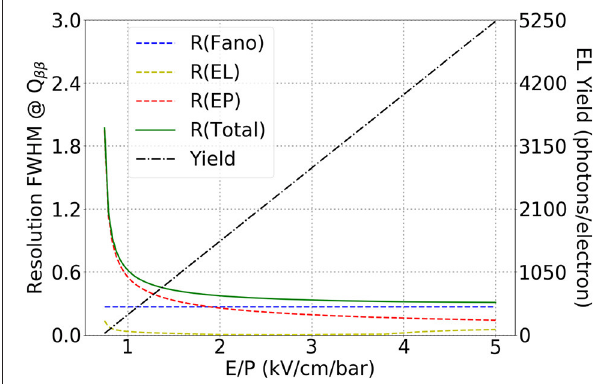
FIGURE 3 | Energy resolution terms and EL yield characteristic of a HPXe-EL TPC as a function of the reduced electric field for an EL gap of 6mm a value of k 0.016 and a pressure of ∼